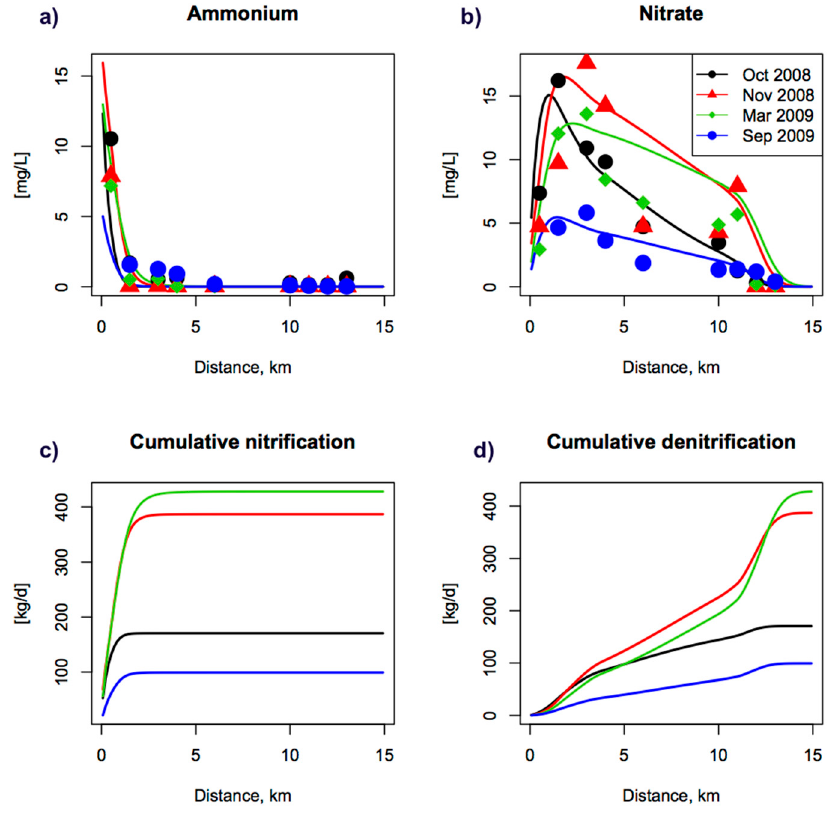
Figure 3. Simulated (line) and measured (circle) concentrations of nitrate ‐ nitrogen and ammonium ‐ nitrogen in the main stream (Chaminé river). From October 2008 to September 2009. Distance refers to the length of the river, from upstream (0 km) to downstream (15 km) versus ( a ) Ammonium concentration; ( b ) Nitrate concentration; ( c ) Cumulative nitrification; and ( d ) Cumulative denitrification. Black line and circles refer to October 2008, red line and triangles refer to November 2008, Green line and diamonds are associated to March 2009 and blue line and circles refer to September 2009.